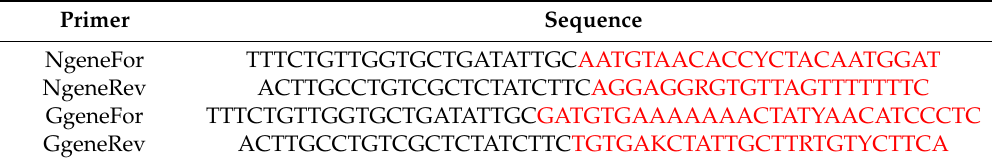
Table 1. Primers used in this study. Sequences are in 5 (cid:48) to 3 (cid:48) orientation. Red colored bases correspond to the rabies virus genome binding sequence. Black nucleotides at the 5 (cid:48) end were used to add barcode sequences for multiplexing. Red sequences correspond to positions 54 to 76 (NgeneFor), 1475 to 1496 (NgeneRev), 3273 to 3300 (GgeneFor), and 5264 to 5288 (GgeneRev) in rabies virus strain